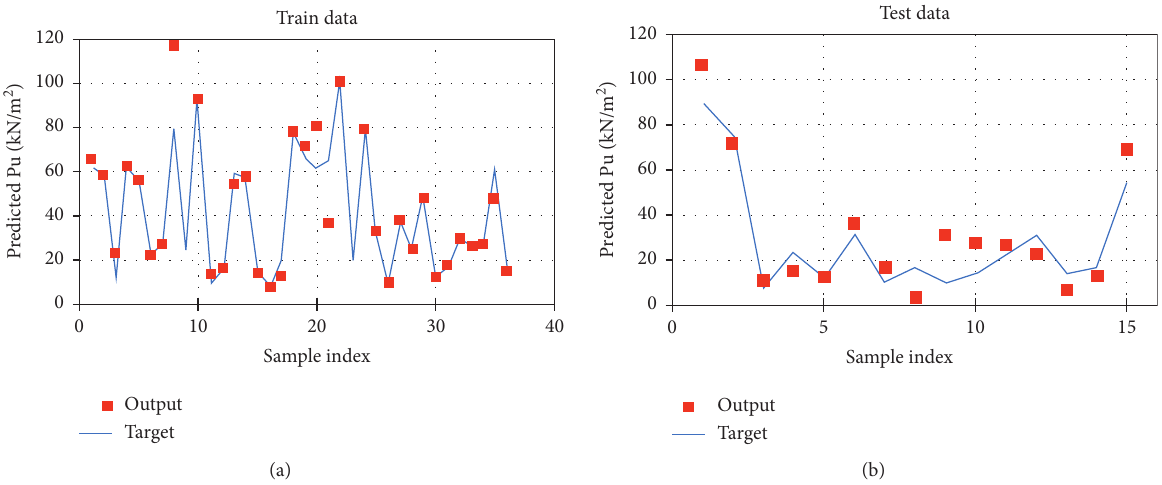
Figure 5: Predicted compressive strength of stabilized dredged sediments by the ANN model. (a) Training. (b)